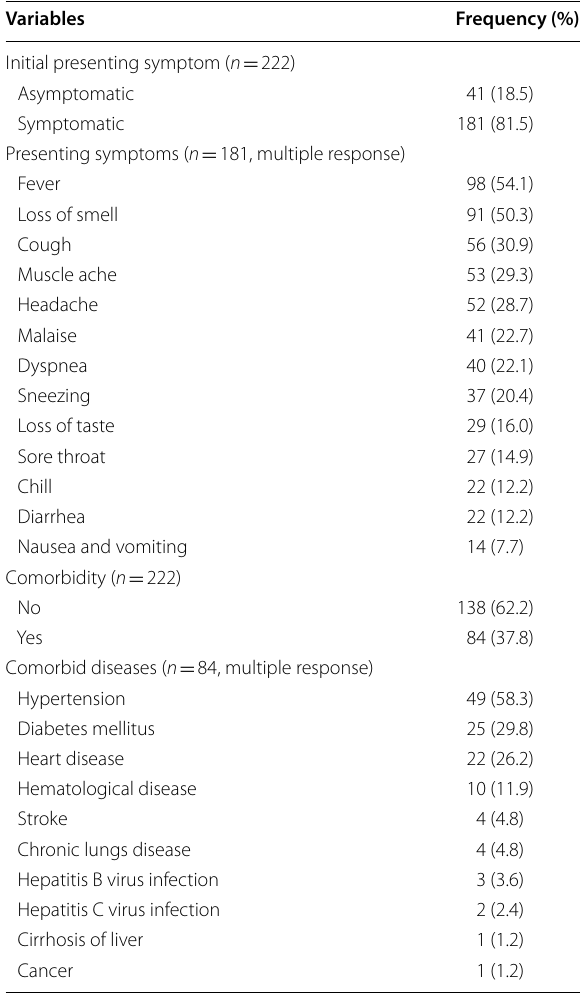
Table 2 Initial presenting symptoms and comorbidities of COVID-19 patients